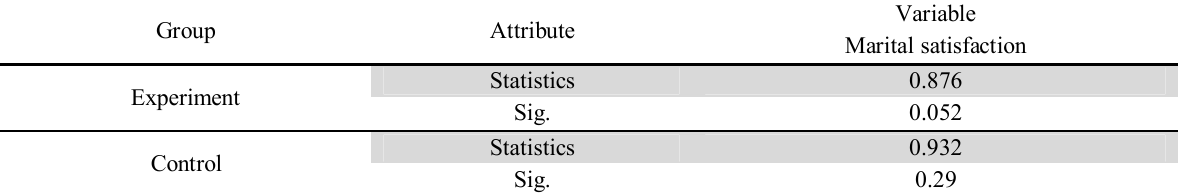
Variable Marital satisfaction